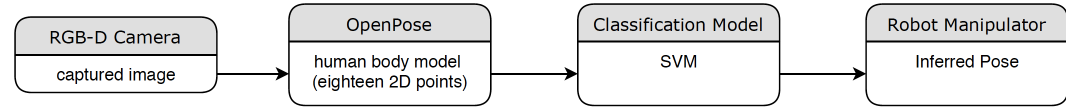
Figure 10. The workflow proposed in the paper to obtain, from the acquired image and using the learned cubic SVM model, the inferred pose to be sent to the robot